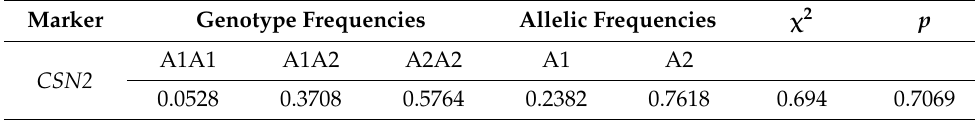
Table 4. Genotype and allelic frequencies in Holstein breeds for CSN2 .